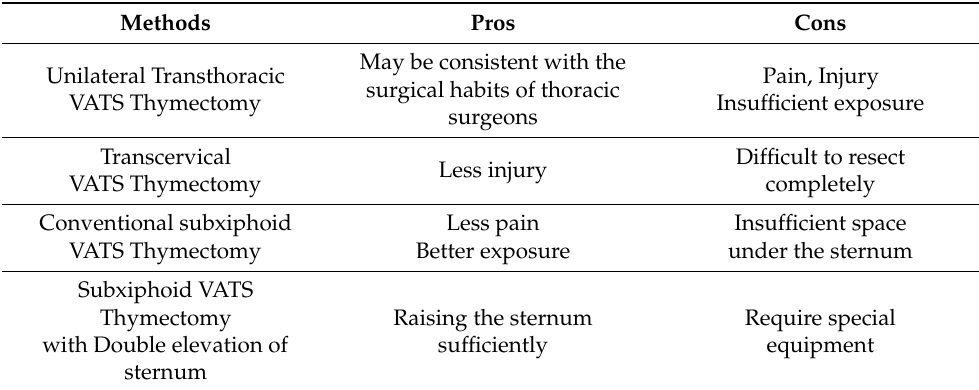
Pain, Injury Insufficient exposure Difficult to resect completely Insufficient space under the sternum Require special